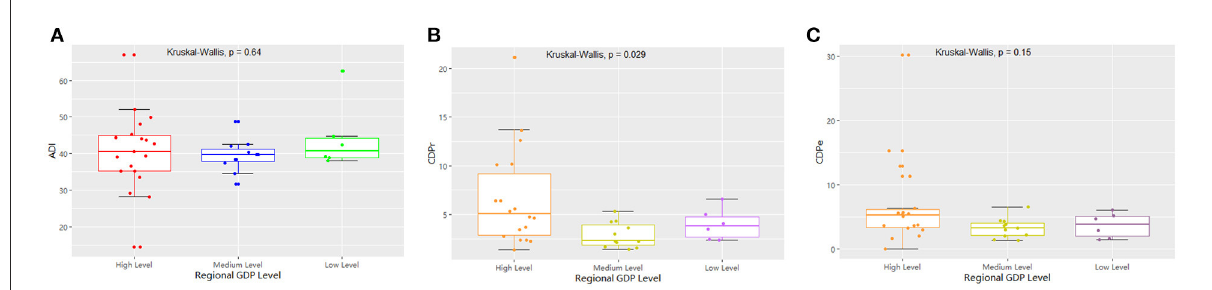
FIGURE7 The comparison of the measured drug used indices of GRNB based on regional per capita